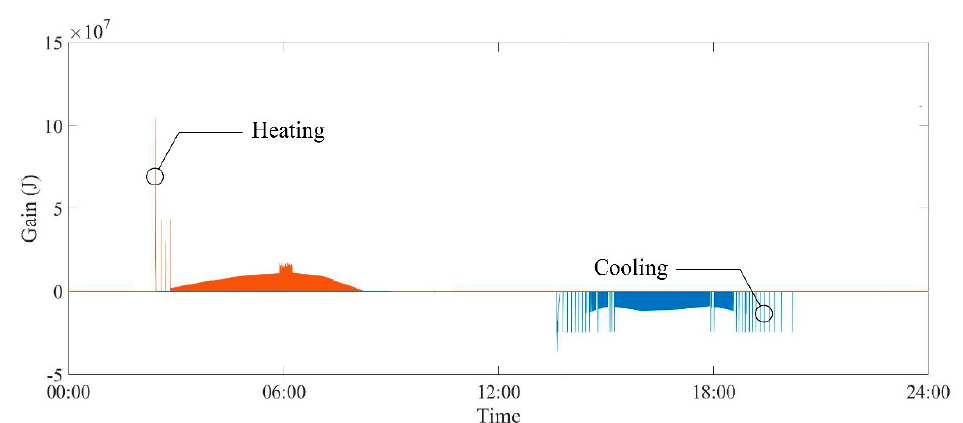
Figure 15. Energy use by Comb at an abnormal condition.